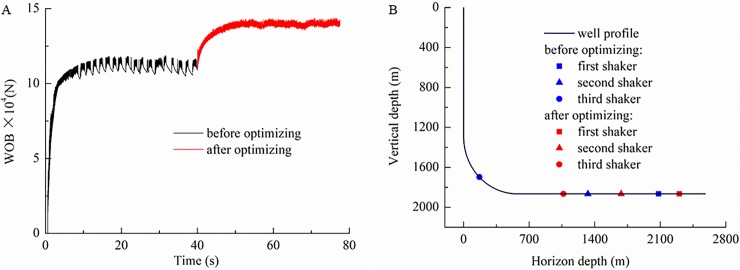
Comparison of WOB and positions of shakers before and after position optimization.(A) Change in weight on bit with time. (B) Change of positions of shakers. https://dx.doi.org/10.17504/protocols.io.kfcctiw.